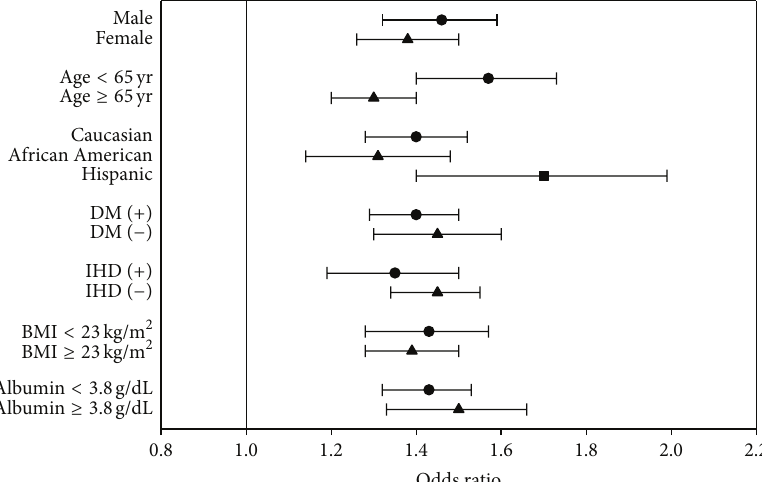
Figure 3: Adjusted mortality risk of weekly epoetin- 𝛼 dose ≥ 30 000 versus < 30000 U/week (reference) among various subgroups. DM = diabetes mellitus, IHD = ischemic heart disease, and BMI = body mass